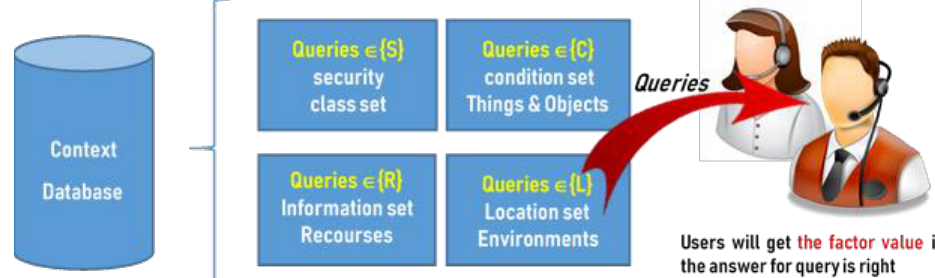
Figure 2. Context database and query set for the proposed digital sharing system.